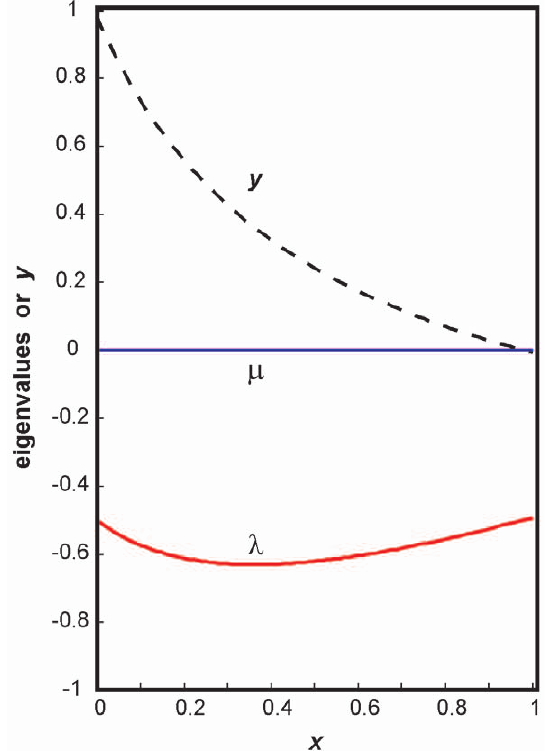
Figure 4.The eigenvalues in the critical region of the bifurca- tion as a function x . Note that m is zero for all x (blue) and that there is a minimum in l (red) (see text for details). Shown is also the position of the steady state in the y dimension as function or x (dashed line, = stable degenerate manifold, Eq. 3.14).